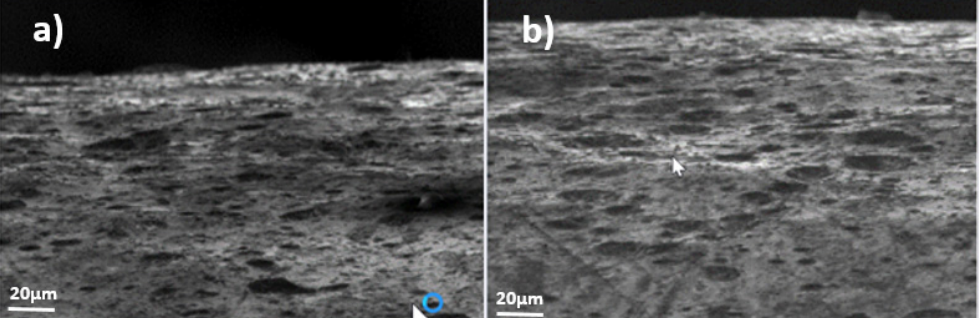
Figure 12. Example of surface evolution in hot-dip galvanizing zinc coating (sample 4) under compressive stresses (F); ( a ) month 1, ( b ) month 12.